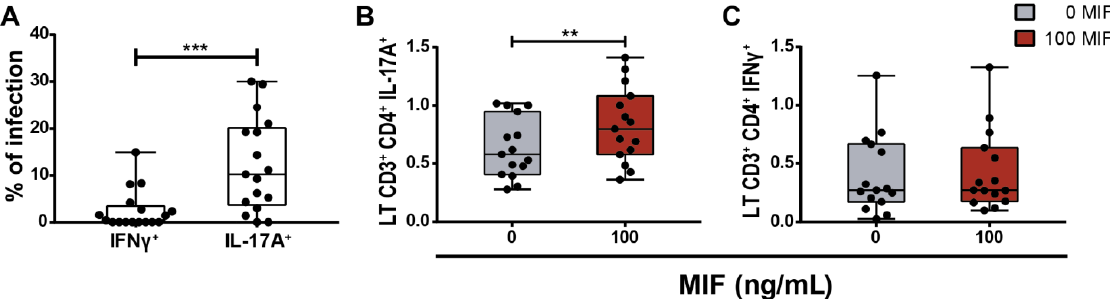
Figure 8. Evaluation of PBMCs from PWH response to MIF stimulus in an ex vivo model. ( A ) Ex vivo HIV-infection percentage in IL-17A- and IFNγ -expressing CD4TLs derived from PBMCs of PWH. ( B ) IFNγ intracellular expression on CD4TLs after 24 h of treatment with 100 ng/mL of MIF. ( C ) IL-17A intracellular expression on CD4TLs after 24 h of treatment with 100 ng/mL of MIF. Both experiments were performed on PBMCs and the results were standardized to the positive control (PBMCs treated with α CD3/ α CD28-binding antibodies). Data represent the median ± IQR25-75 of 15 independent donors, each one with one replicate. Data analysis was performed with a Student’s t -test. ** p < 0.01, *** p <